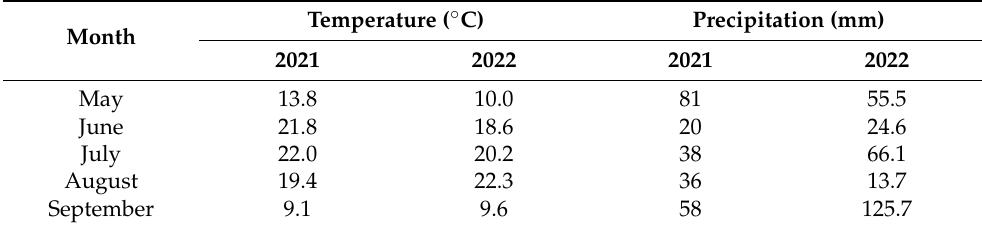
Table 7. Monthly temperature and precipitation in 2021 and